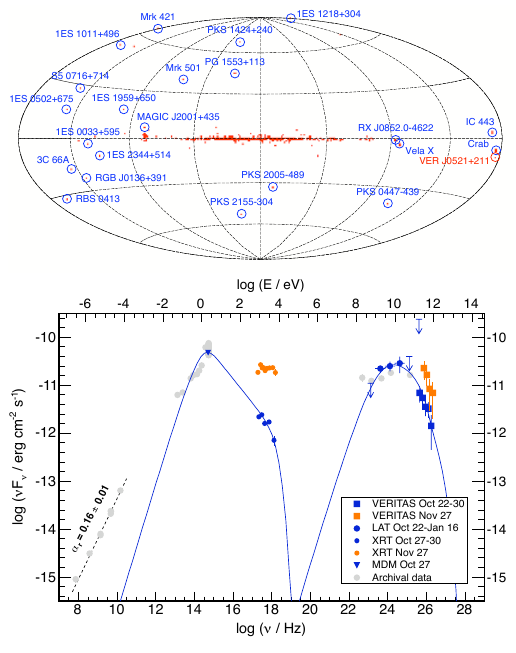
Figure 7. (a) (Top) Map in Galactic coordinates showing the arrival directions of all di ff use class photon events with zenith angle < 105 ◦ recorded by Fermi -LAT in the first year of obser- vations between 2008 Aug 4 and 2009 Aug 25, with energies greater than 30 GeV [21]. (b) (Bottom) Broadband spectral en- ergy distribution of VER J0521 + 211 during the VERITAS de- tection in 2009. The orange markers correspond to the flare data. The solid blue curve represents a one-zone SSC emission model with parameters adjusted to describe the low-state data. For de- tails on the broadband data and modeling results, see [21]. Both figures are taken from